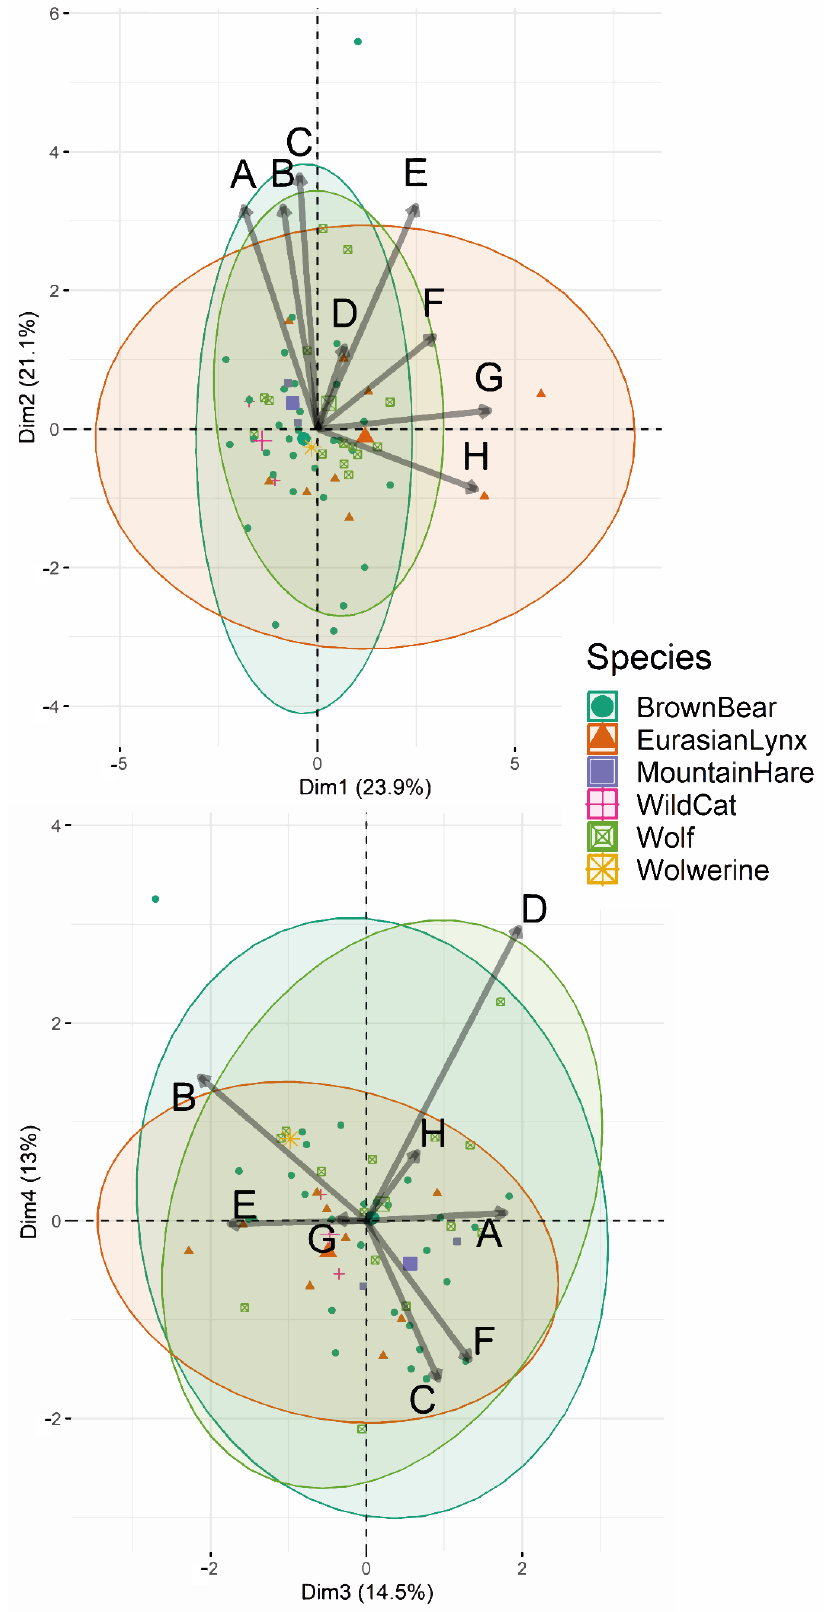
Figure A2. Biplot of variables and individuals classed by studied species (GDD – PCA).